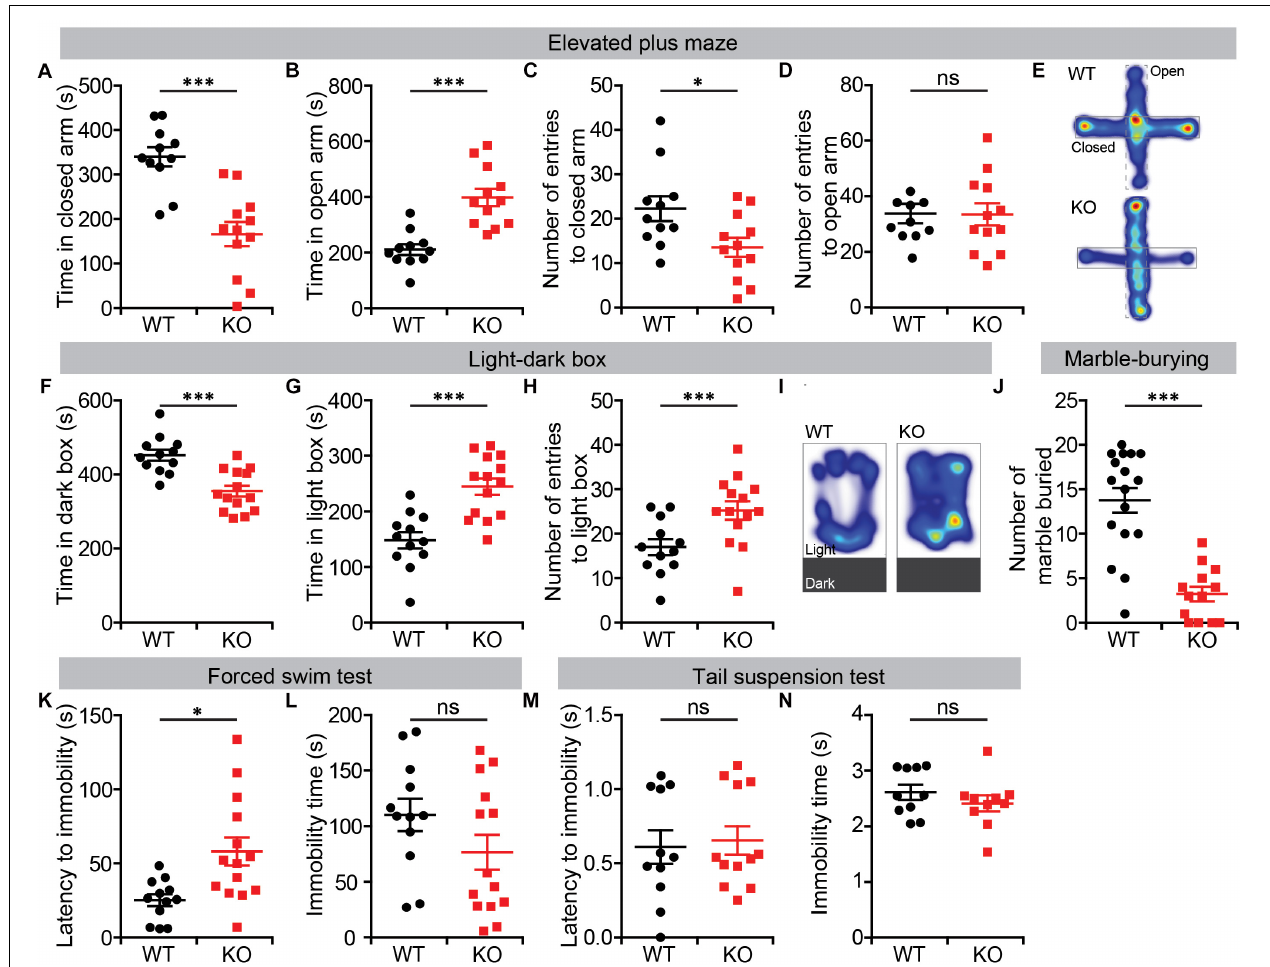
FIGURE 2 | Anxiolytic-like behavior and largely normal depression-like behavior in Lrrc4c − / − mice. (A–E) Anxiolytic-like behavior in Lrrc4c − / − mice (2–5 months; male) in the EPM, as shown by time spent in closed/open arms, number of entries into closed/open arms and heat map (10 min). n = 11 (WT), n = 12 (KO), ∗ p < 0.05, ∗∗∗ p < 0.001, ns, not significant, Student’s t-test [ (A) t ( 21 ) = 4.944; p < 0.0001; (B) t ( 21 ) = 5.02; p < 0.001; (C) t ( 8 ) = 3.084; p = 0.0150; (D) t ( 21 ) = 0.6721; p = 0.5088]. (F–I) Anxiolytic-like behavior in Lrrc4c − / − mice (2–5 months; male) in the light–dark test, as shown by time spent in the dark/light box, number of entries into the light box, and heat map (10 min). n = 12 (WT), n = 14 (KO), ∗∗∗ p < 0.001, Student’s t-test [ (F) t ( 24 ) = 4.603; p = 0.0001; (G) t ( 24 ) = 4.603; p = 0.0001; (H) t ( 10 ) = 6.195; p = 0.0001]. (J) Suppressed marble burying in Lrrc4c − / − mice (2–5 months; male) in the marble-burying test (10 min). n = 17 (WT), n = 13 (KO), ∗∗∗ p < 0.001, Student’s t-test [ (J) t ( 28 ) = 6.021; p < 0.001]. (K,L) Anti-depression–like behavior in Lrrc4c − / − mice (2–5 months; male) in